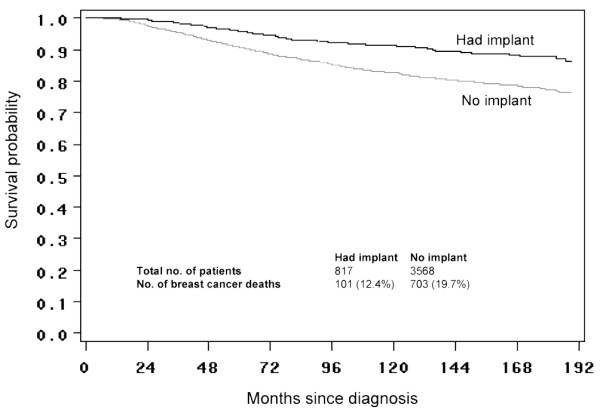
Age-adjusted breast cancer survival curve by breast implant status, 1983–1989.